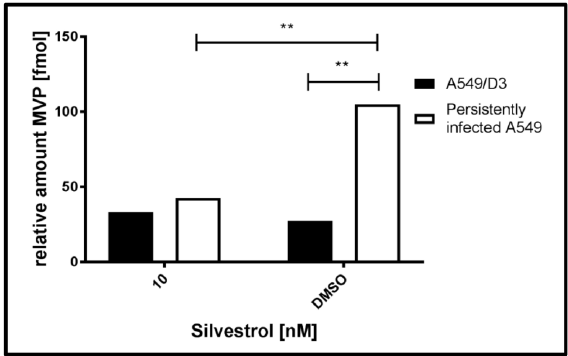
Figure 7. Induction of MVP expression upon HEV infection and subsequent cytosolic decrease by 10 nM silvestrol treatment (24 h) as measured by ultradefinition mass spectrometry (UDMS E ) and depicted in Table 1. n = 3; ** p <